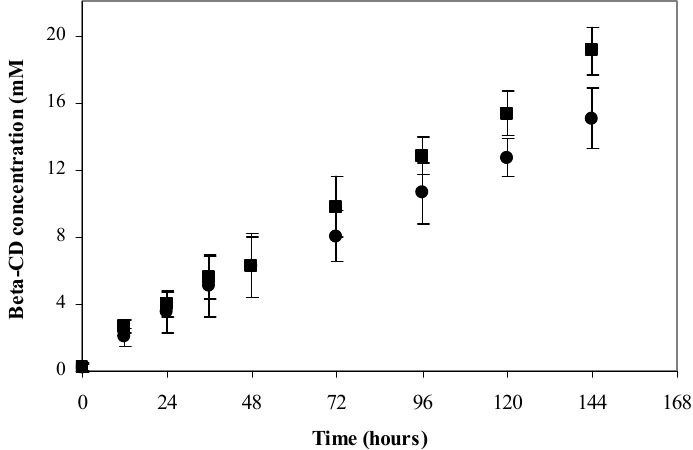
Figure 2. Evaluation of B. firmus strain 37 preservation by lyophilization. β -CD production by cells newly lyophilized ( ■ ) and after one year of storage ( ●